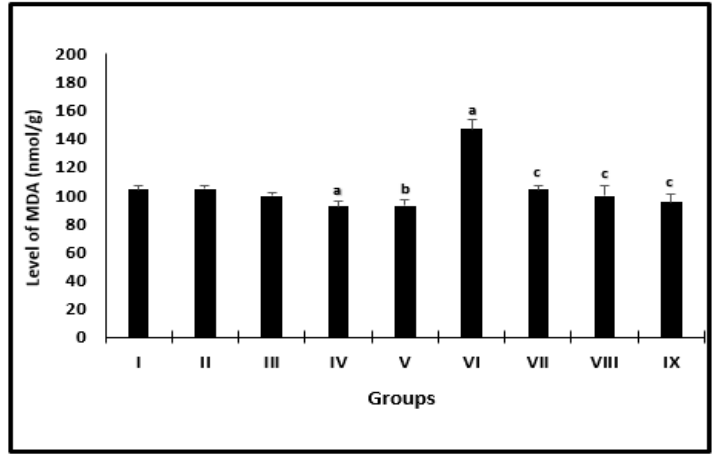
Figure 3. Liver MDA level of mice after 2 weeks of treatment. a significant difference from the saline group, b significant difference from the phosphate buffer group, c significant difference from the